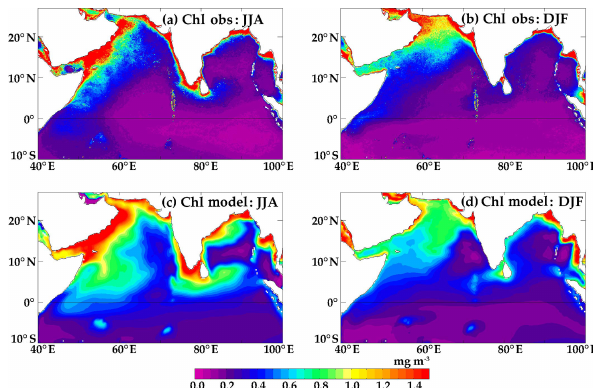
Figure 2. Northern Indian Ocean surface chlorophyll (mgm − 3 ) climatology for ( a, c ) summer (June–August) and ( b, d ) winter (December–February) in ( a, b ) the ESA satellite product and ( c, d )